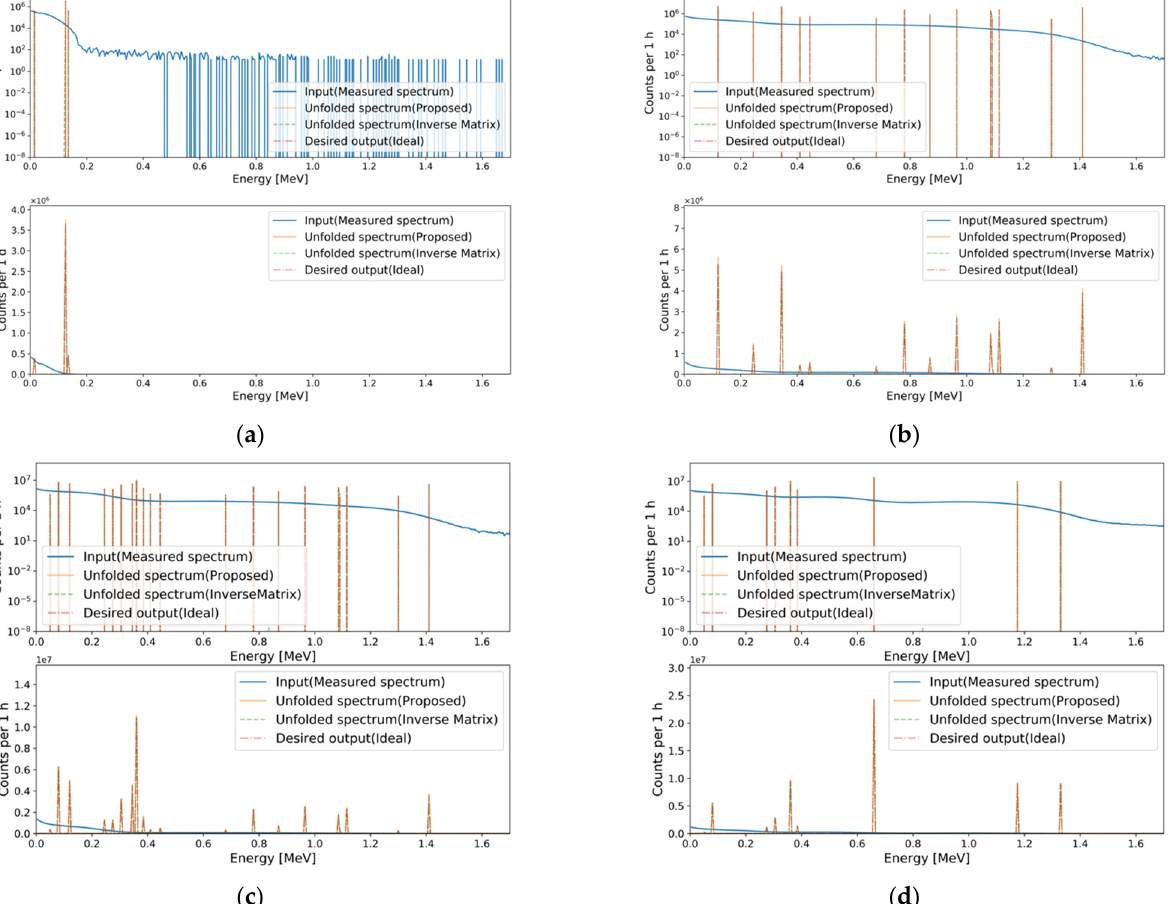
Figure 11. Examples of the unfolding results using the inverse of the transfer matrix and the final MTL model from fine measured spectra, from single to multiple gamma-ray sources. Results of ( a ) 57 Co; ( b ) 152 Eu; ( c ) 133 Ba and 152 Eu; ( d ) 60 Co, 133 Ba and 137 Cs. The MAPEs of the inverse of the transfer matrix and final MTL model, respectively, are ( a ) 1.428 × 10 − 6 and 1.538 × 10 − 2 ; ( b ) 3.044 × 10 − 5 and 1.486 × 10 − 1 ; ( c ) 3.277 × 10 − 5 and 5.752 × 10 − 2 ; ( d ) 2.590 × 10 − 5 and 6.046 × 10 − 2 .